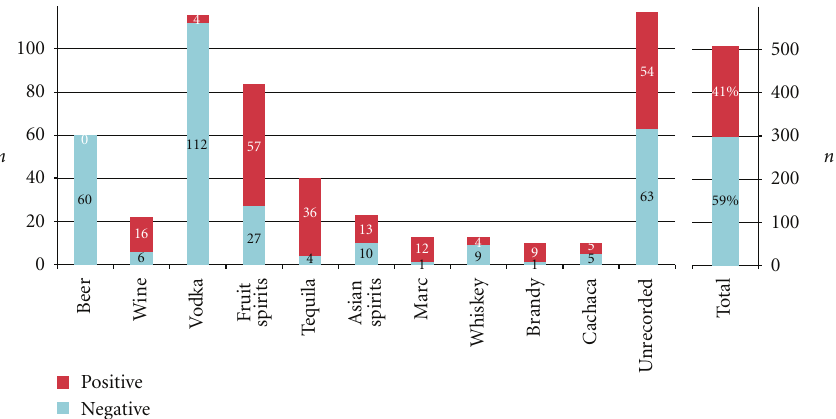
Figure 5: Results of the screening using purpald